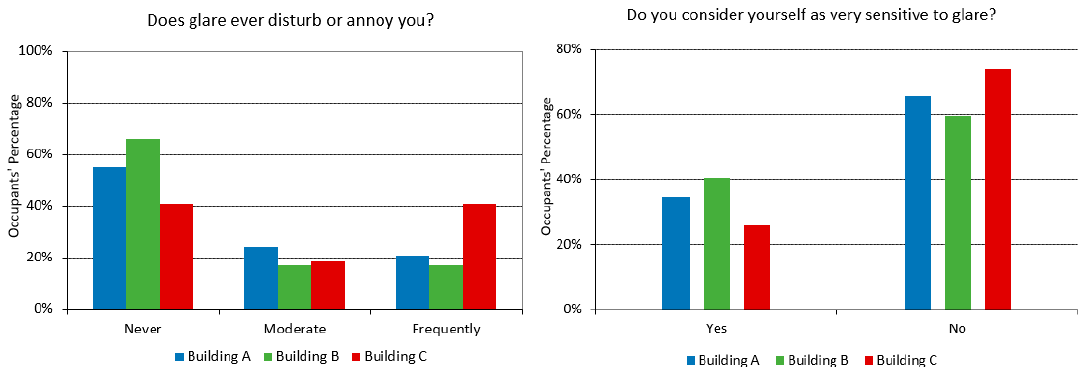
Figure 22. Results of how frequent the users are disturbed from glare ( left ) and if they consider themselves sensitive to glare ( right ).